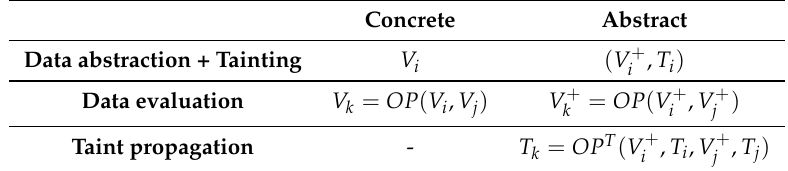
Table 2. Comparison of data evaluation and taint propagation between concrete and abstract